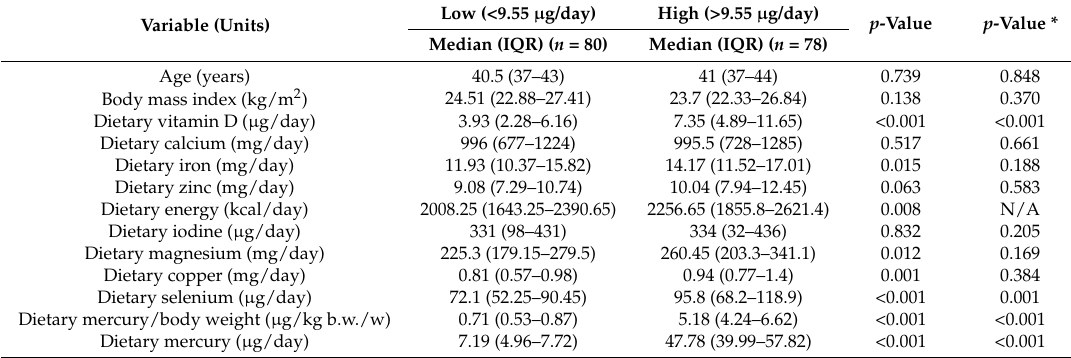
Table 3. Sample characteristics regarding mercury dietary intake in premenopausal women. Variable